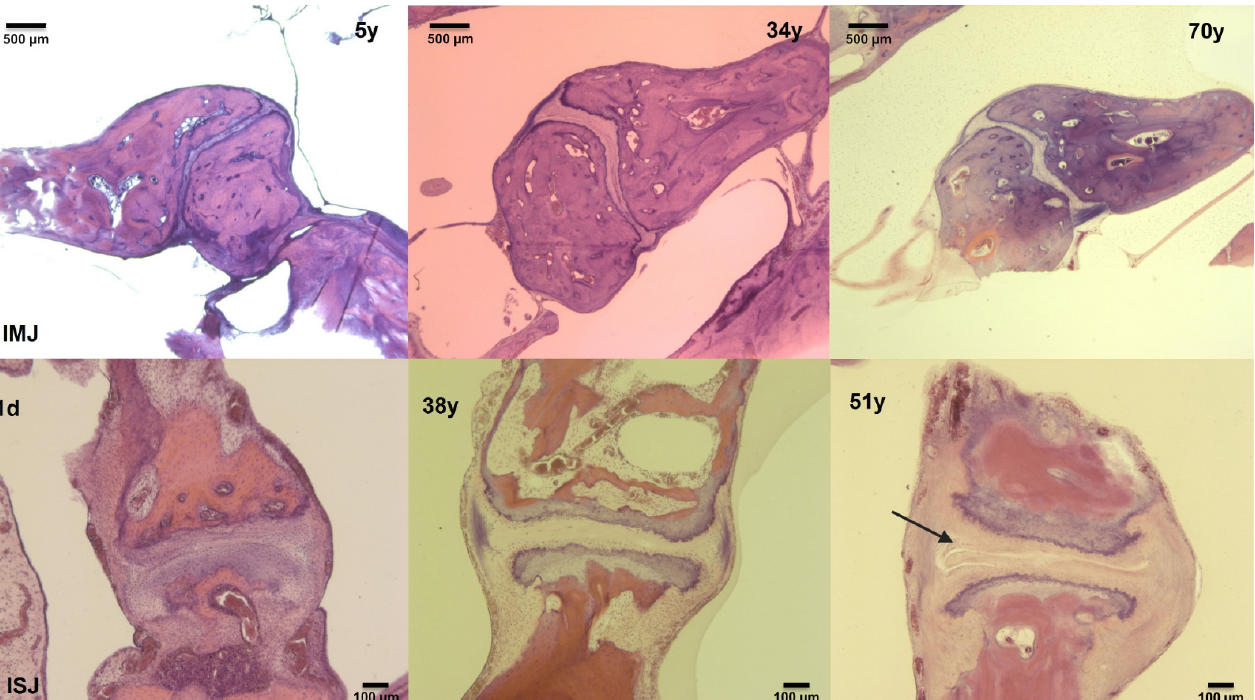
Figure 2. Comparison of hematoxylin- and eosin-stained histologic sections of the incudo-mallear joint (IMJ; top line) and incudo-stapedial joint (ISJ; lower line) from young ( left ), middle and older ( right ) subjects showing increasing width of the discus of the IMJ and the posterior part of the ISJ (arrow) with age. The specific age in days (d) or years (y) of each subject is displayed in each picture. All IMJ sections are presented in 1.6× magnification; the ISJ sections are in 5× magnification.